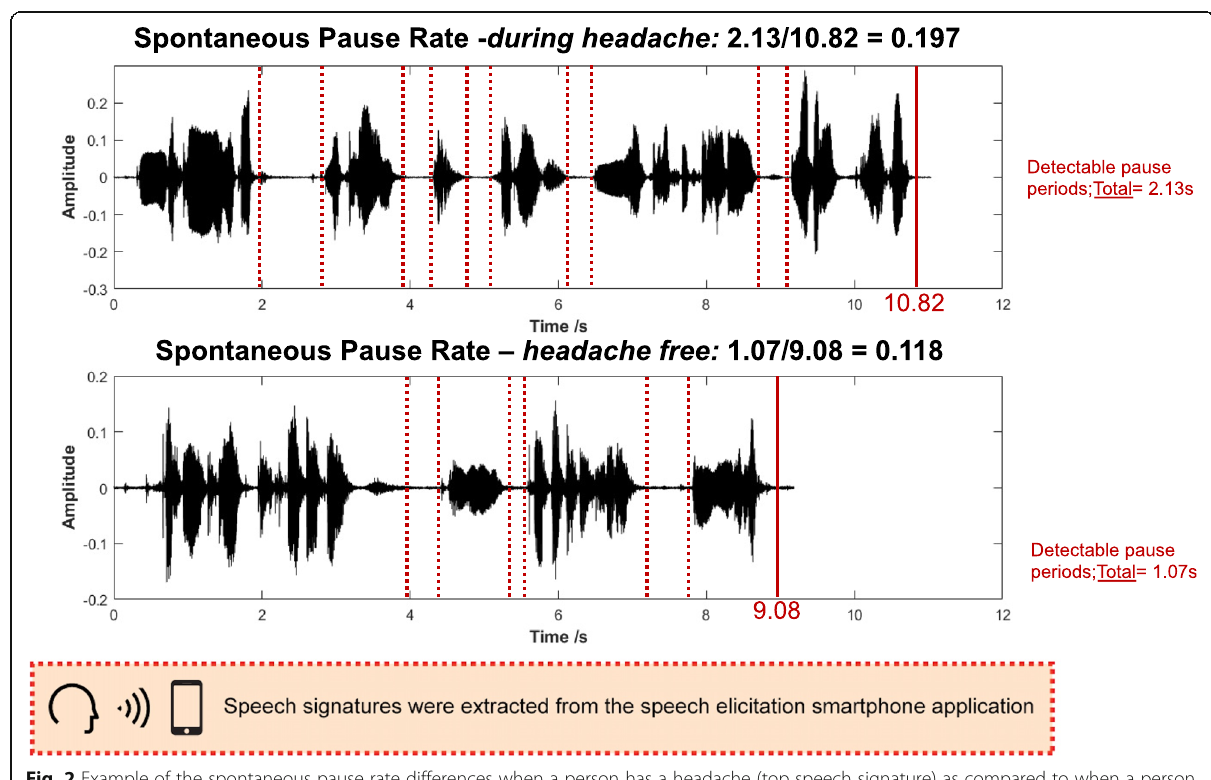
Fig. 2 Example of the spontaneous pause rate differences when a person has a headache (top speech signature) as compared to when a person does not have a